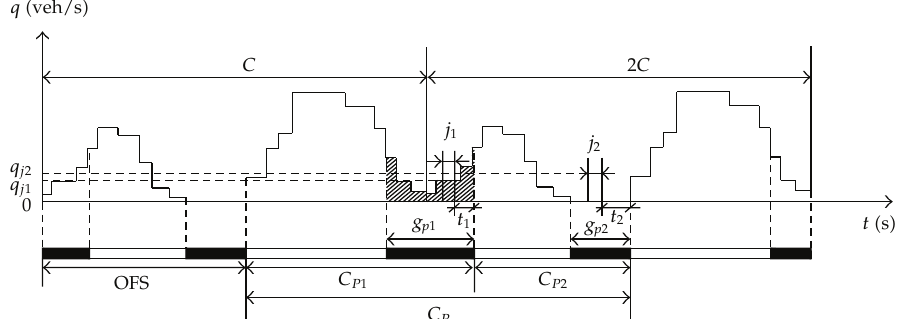
Figure 3: The establishment of first system optimal model on the basis of vehicle flow-time of crosswalk (cid:4) signal double cycles of pedestrian (cid:5) .